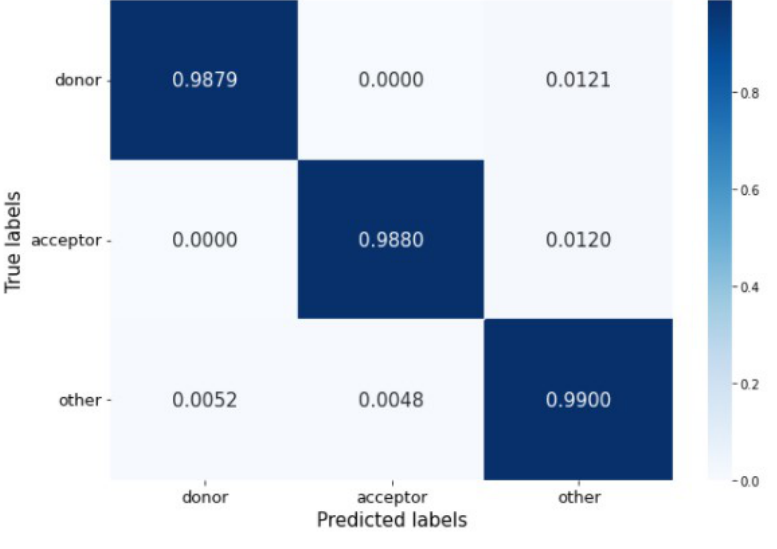
Figure 6. Confusion Matrix of Deep Splicer.